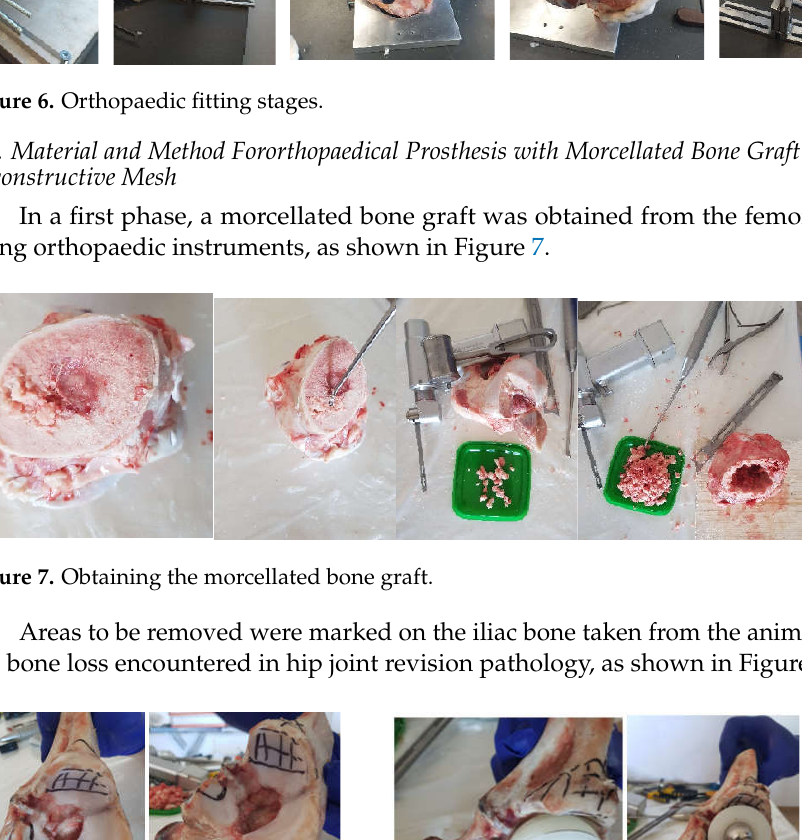
Figure 10. Placement of the bone graft. Next, the reconstructive mesh was prepared and trimmed and adjusted to the re- quired dimensions to cover the morcellated bone graft, as shown in Figure 11. Figure 11. Positioning the reconstructive mesh. In the next step, the reconstructive mesh was fixed using orthopaedical screws, and the positioning of the polyethylene cup was checked, as shown in Figure 12.